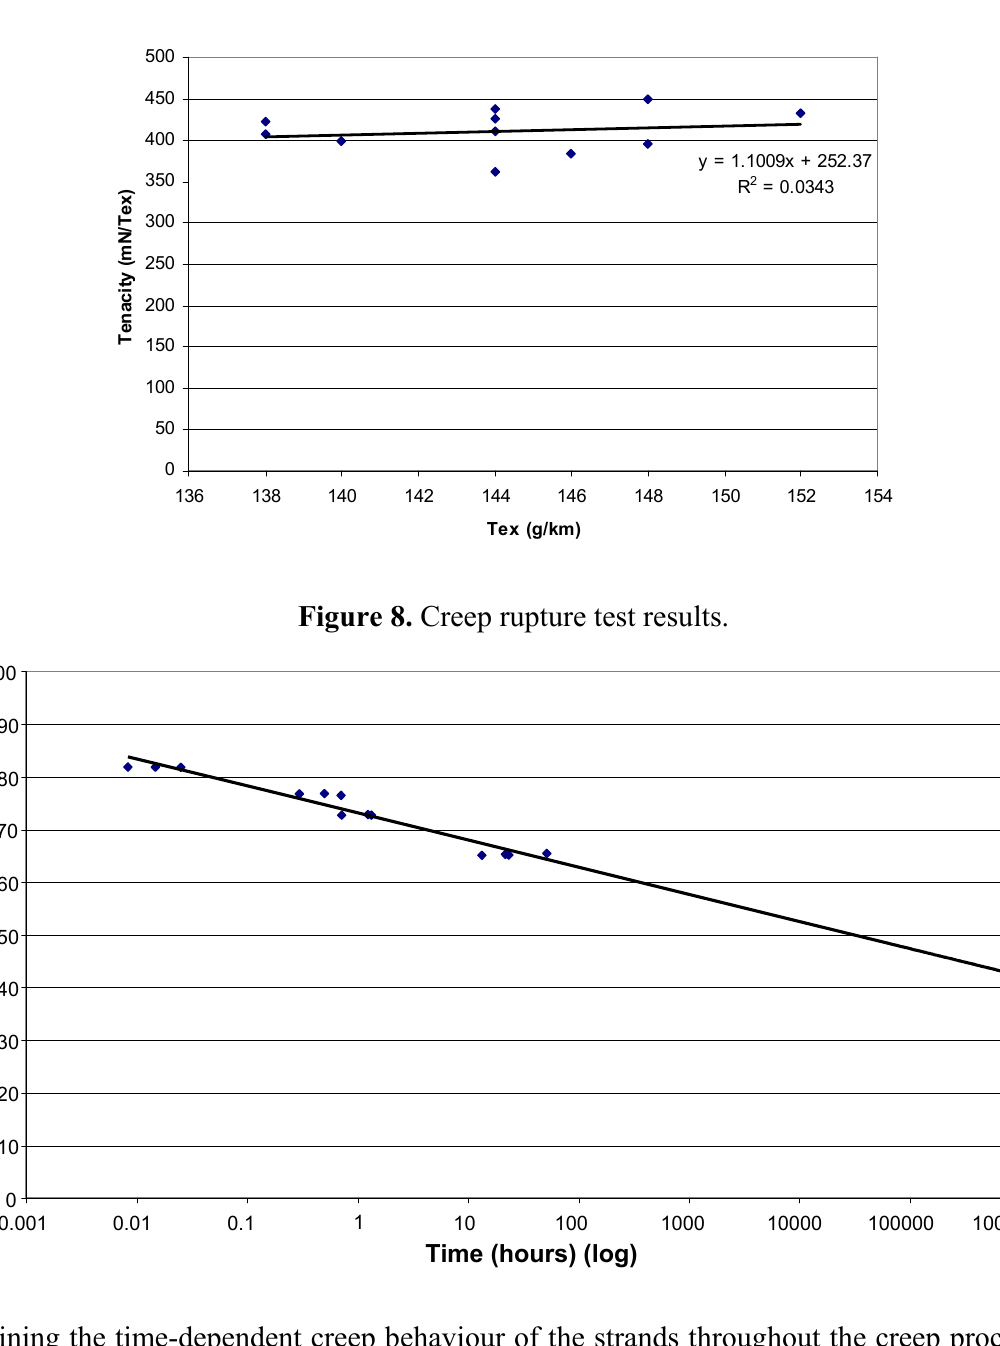
Figure 7. Tenacity (ABL/tex) against strand linear density (tex).